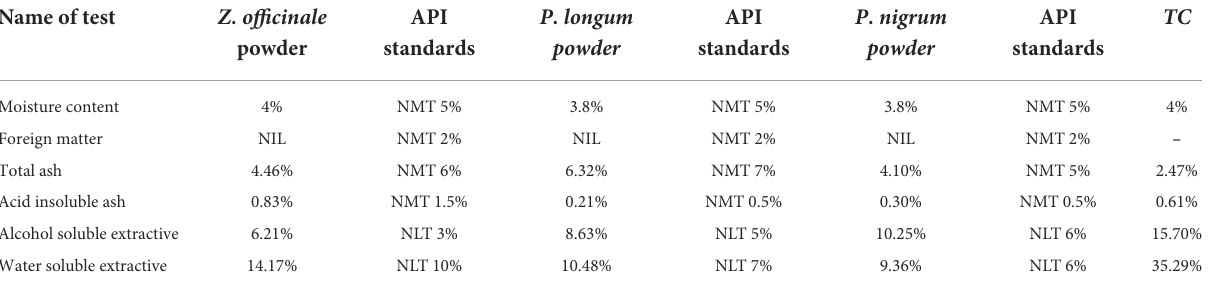
TABLE 4 Physicochemical analysis of prepared herbal